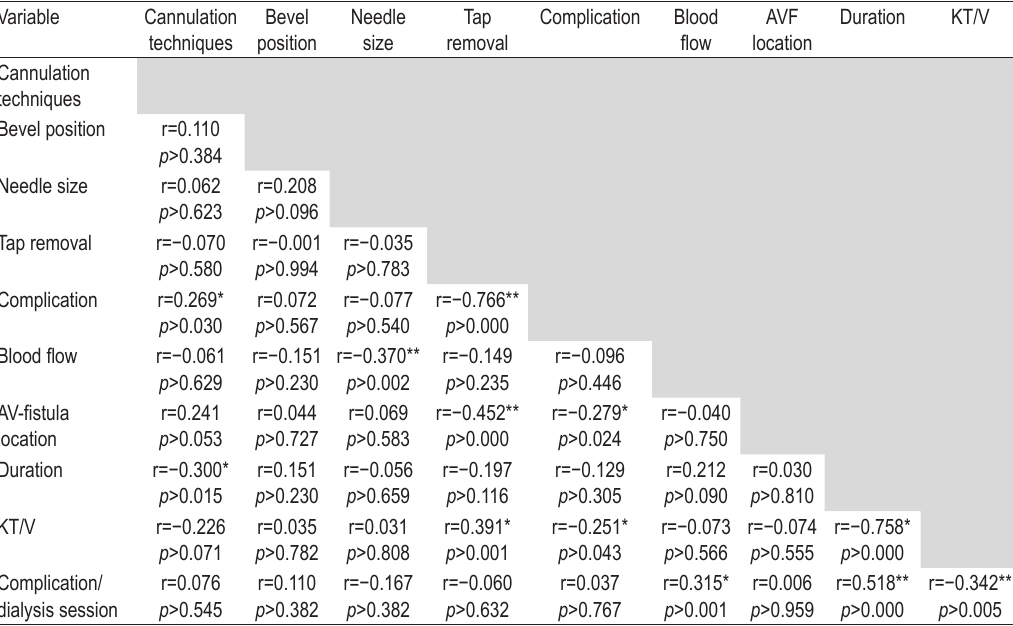
TABLE 4. Correlation matrix of cannulation techniques, bevel position, needle size, tap removal, and complications